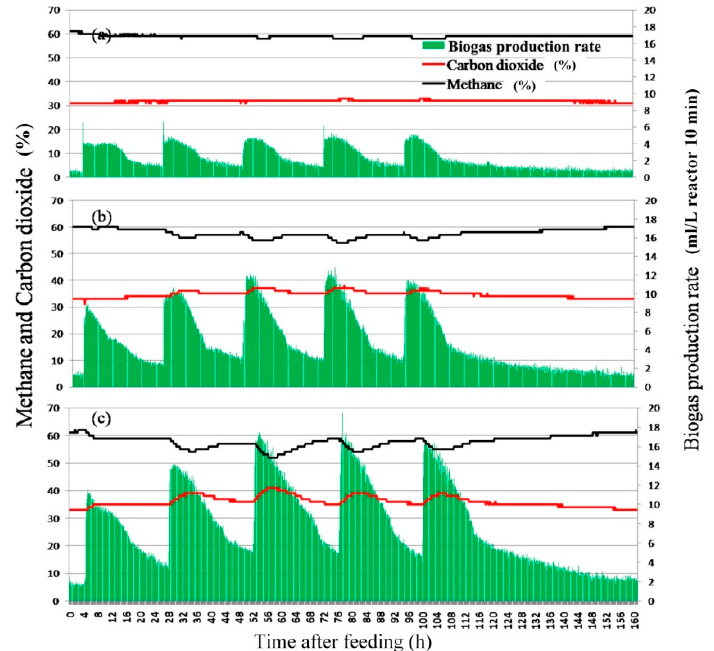
Figure 1. Experimental results of biogas production with feeding once per day: ( a ) Feeding organic loading rate (OLR) = 0.95g COD L − 1 digester day − 1 ; ( b ) feeding OLR = 1.90g COD L − 1 digester day − 1 ; ( c ) feeding OLR = 2.86g COD L − 1 digester day − 1 .